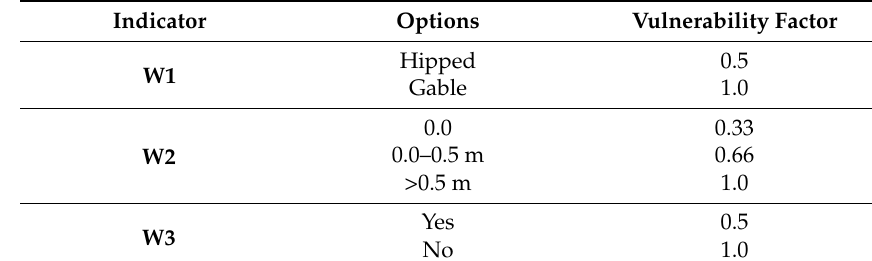
Table 4. Vulnerability scale for wind hazard.